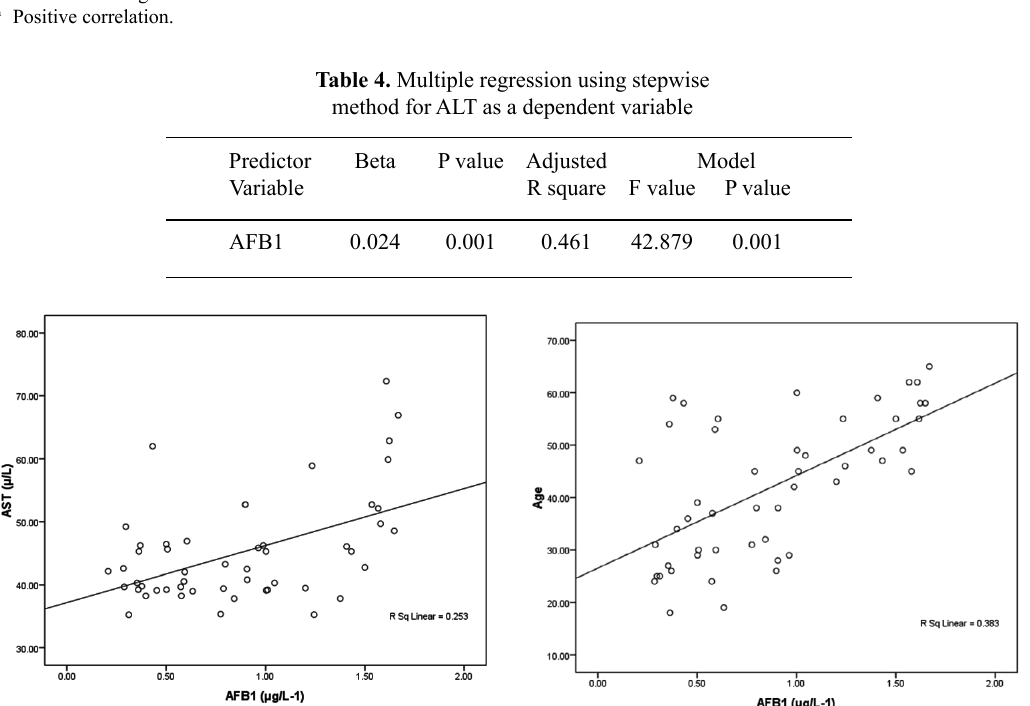
Fig. 4. Correlation between AFB1 (µg/L-1) and Age with best fit line curve (positive correlation)